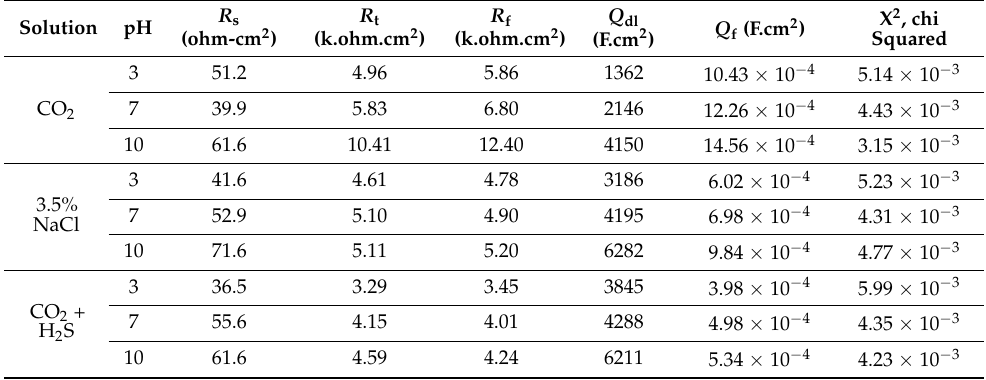
Figure 5. Equivalent circuit for simulating EIS results. Table 2. Electrochemical Impedance Spectroscopy results in different solutions with different pH